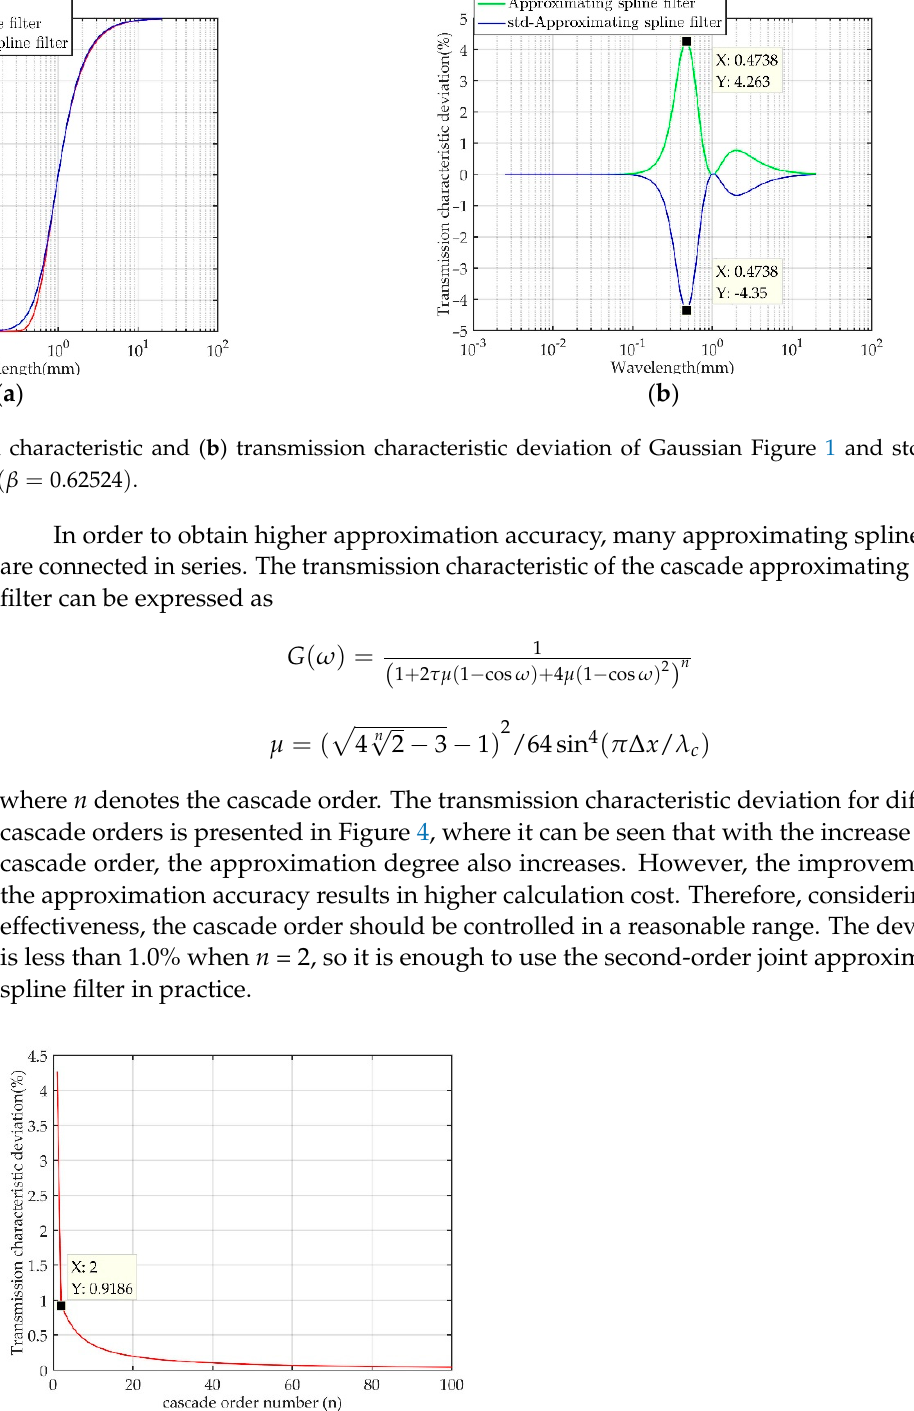
Figure 2. ( a ) Transmission characteristics and ( b ) transmission characteristic deviation of the approximating spline filter (cid:4666)(cid:2028) = 1 √(cid:2020) ,2 √(cid:2020) , and ⁄